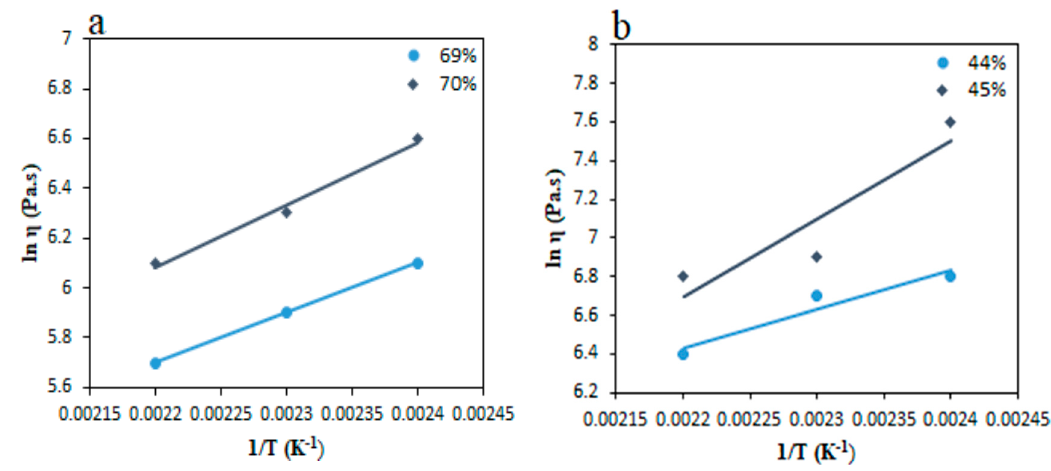
Figure 7. Correlation between viscosity and temperature for the feedstocks: ( a ) SS 17-4PH; and ( b ) 3YSZ.